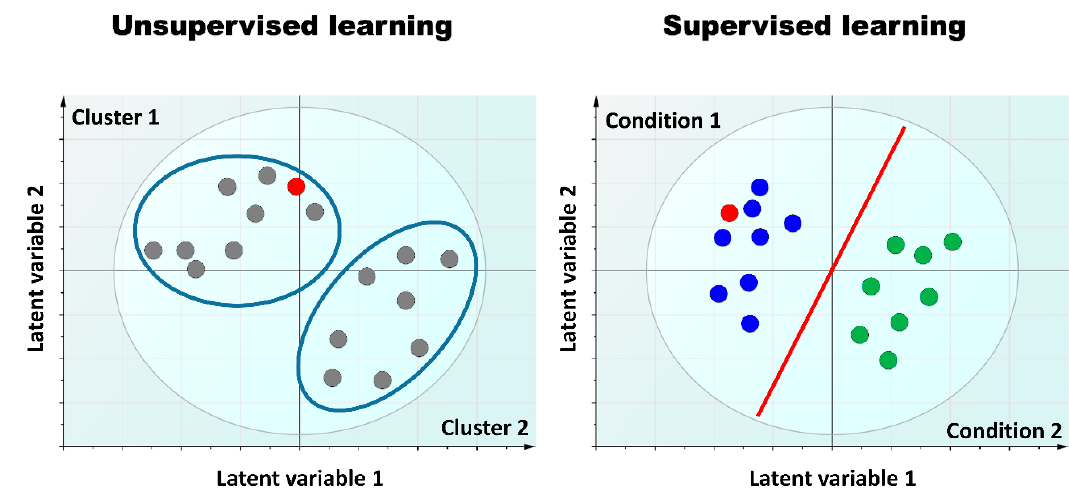
Figure 4. Illustration of the two main machine learning techniques on which omics-based biomarker strategies rely. Left : All samples are unlabeled in unsupervised learning. A model separates samples into different clusters based on their biological similarity. A new sample (red circle) is classified according to its similarity to a particular cluster; Right : In supervised learning, a training dataset of samples with known class labels is used to build a model (blue circle for condition 1 and green circle for condition 2). The model maximizes the difference between samples from condition 1 and condition 2. Based on this learning, a label for a new sample (red circle) is determined.